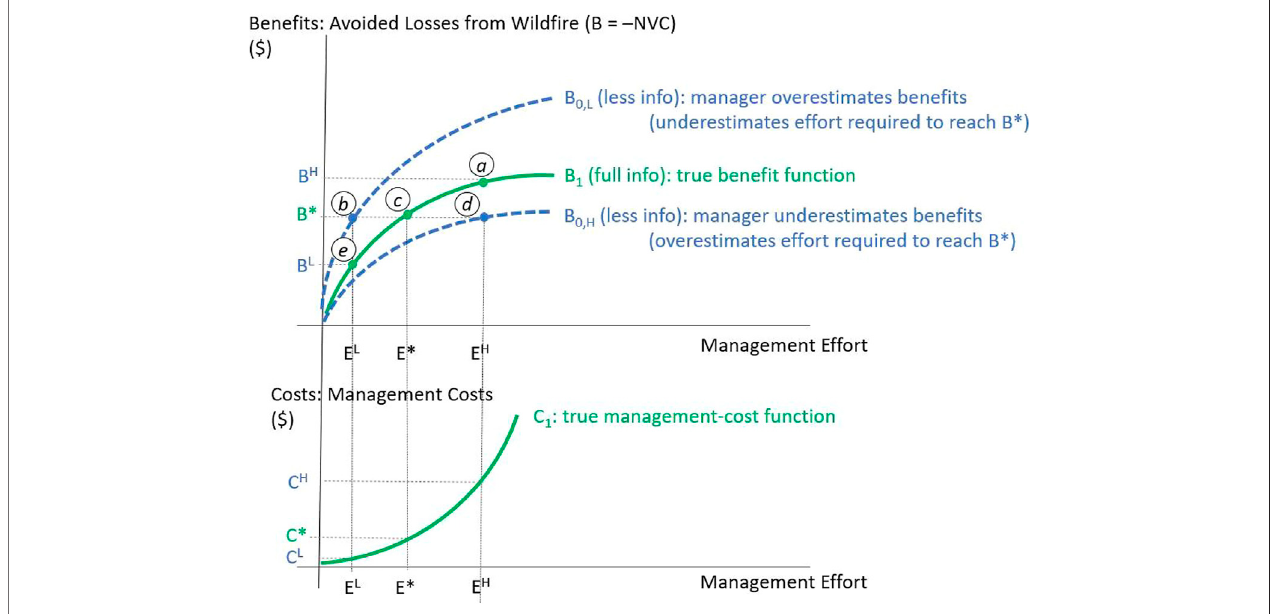
FIGURE 1 | Total bene fi t and total cost functions.